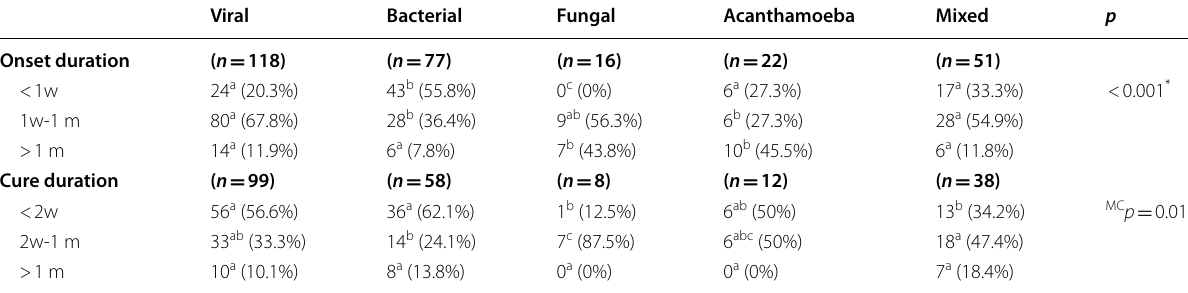
Numbers with different letters are significant MC Monte carlo, p : p -value for comparing between the studied groups * Statistically significant at p ≤